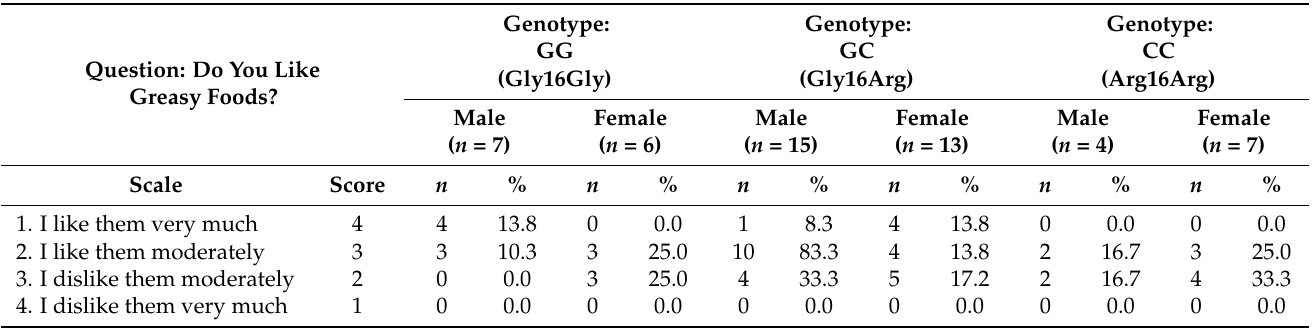
Table 6. The response to a question on greasy food preference in male and female subjects with the GG (Gly16Gly), GC (Gly16Arg), and CC (Arg16Arg) genotypes of ADRB2 .